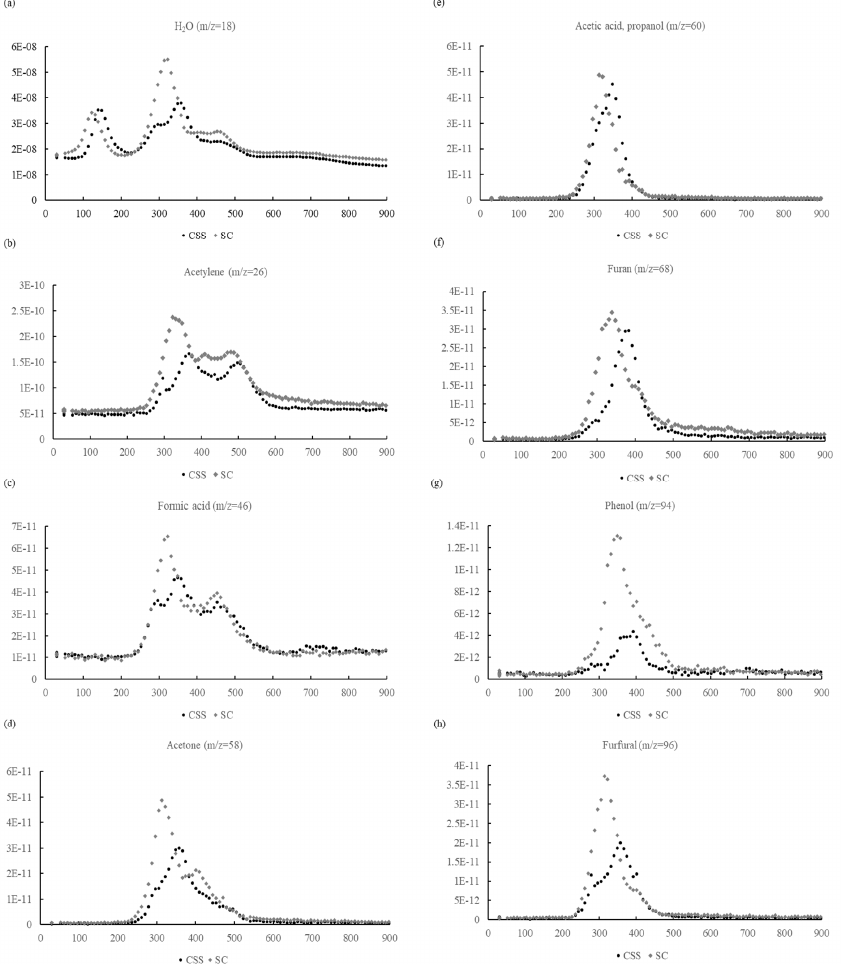
Figure 4. Thermograms of some selected released compounds during TGA (arbitrary units vs temperature in °C).